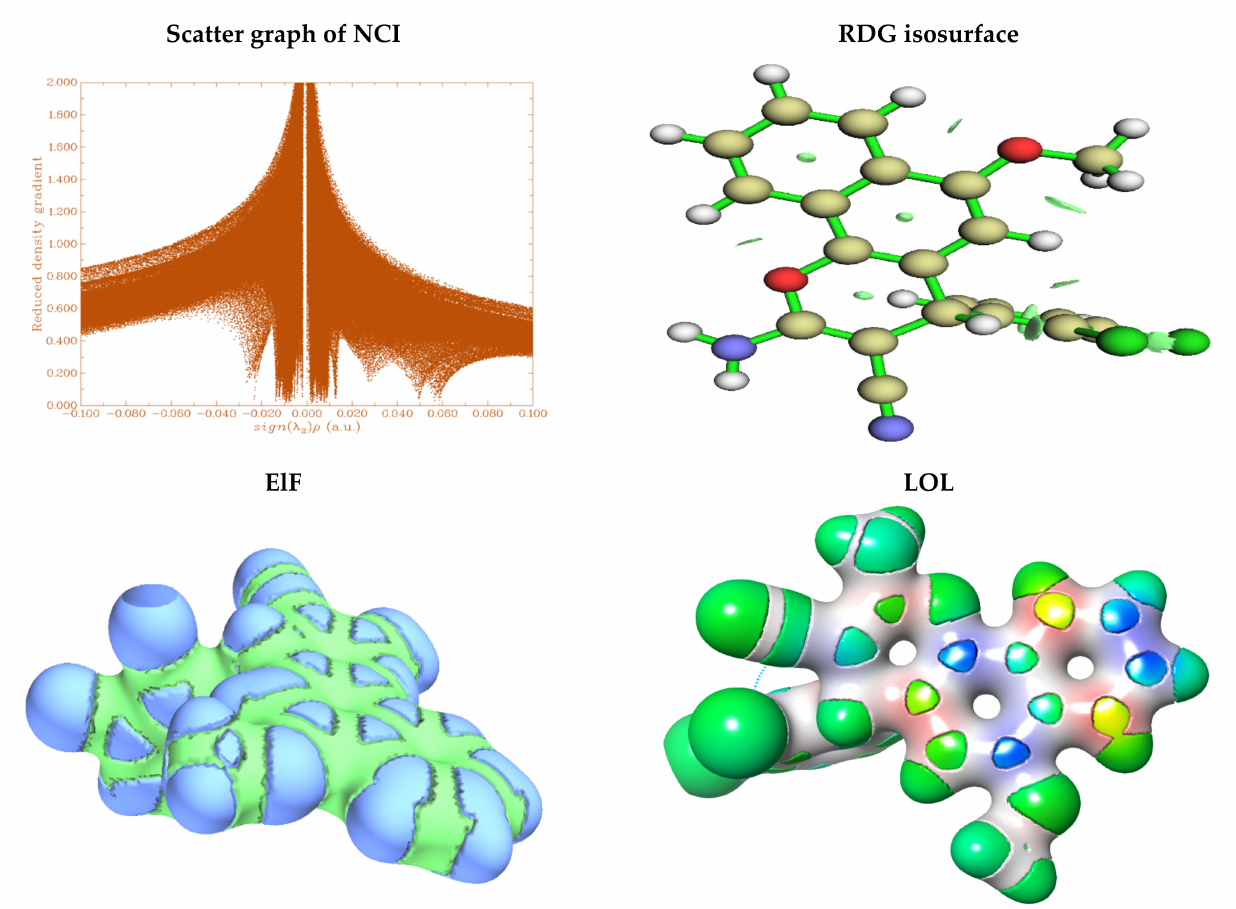
Figure 4. Different weak interaction types for compound 4